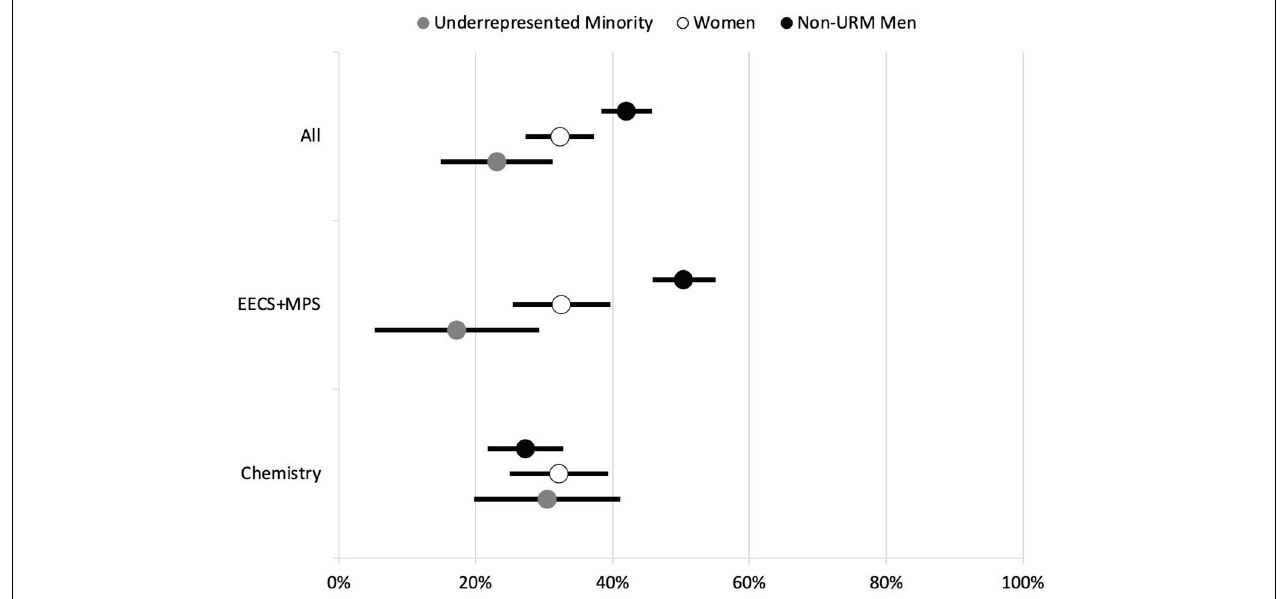
FIGURE 2 | Berkeley doctoral student paper submission rates in the mathematical, physical, and computer sciences. Self-reported paper submission rates differ greatly among URMs (African American, Chicanx/Latinx, and Native American/Alaska Native), women, and non-URM men for Berkeley Ph.D. students in the mathematical, physical, and computer sciences with non-URM men having the highest rates of papers submitted for publication (42%) followed by women (32%) and then URMs (23%). These differences are exacerbated in Electrical Engineering and Computer Science (EECS) and Mathematical and Physical Sciences (MPS) but disappear in Chemistry. Error bars show 95th percentile confidence intervals. Figure adapted from Mendoza-Denton et al.